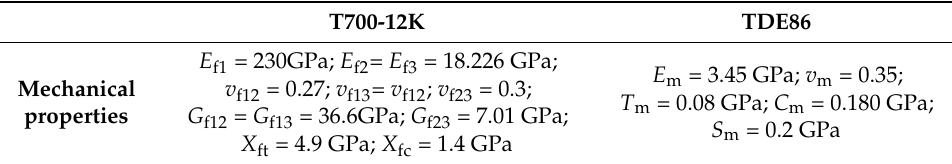
Figure 5. Sketch with the dimension for ( a ) tensile and ( b ) compressive specimens.